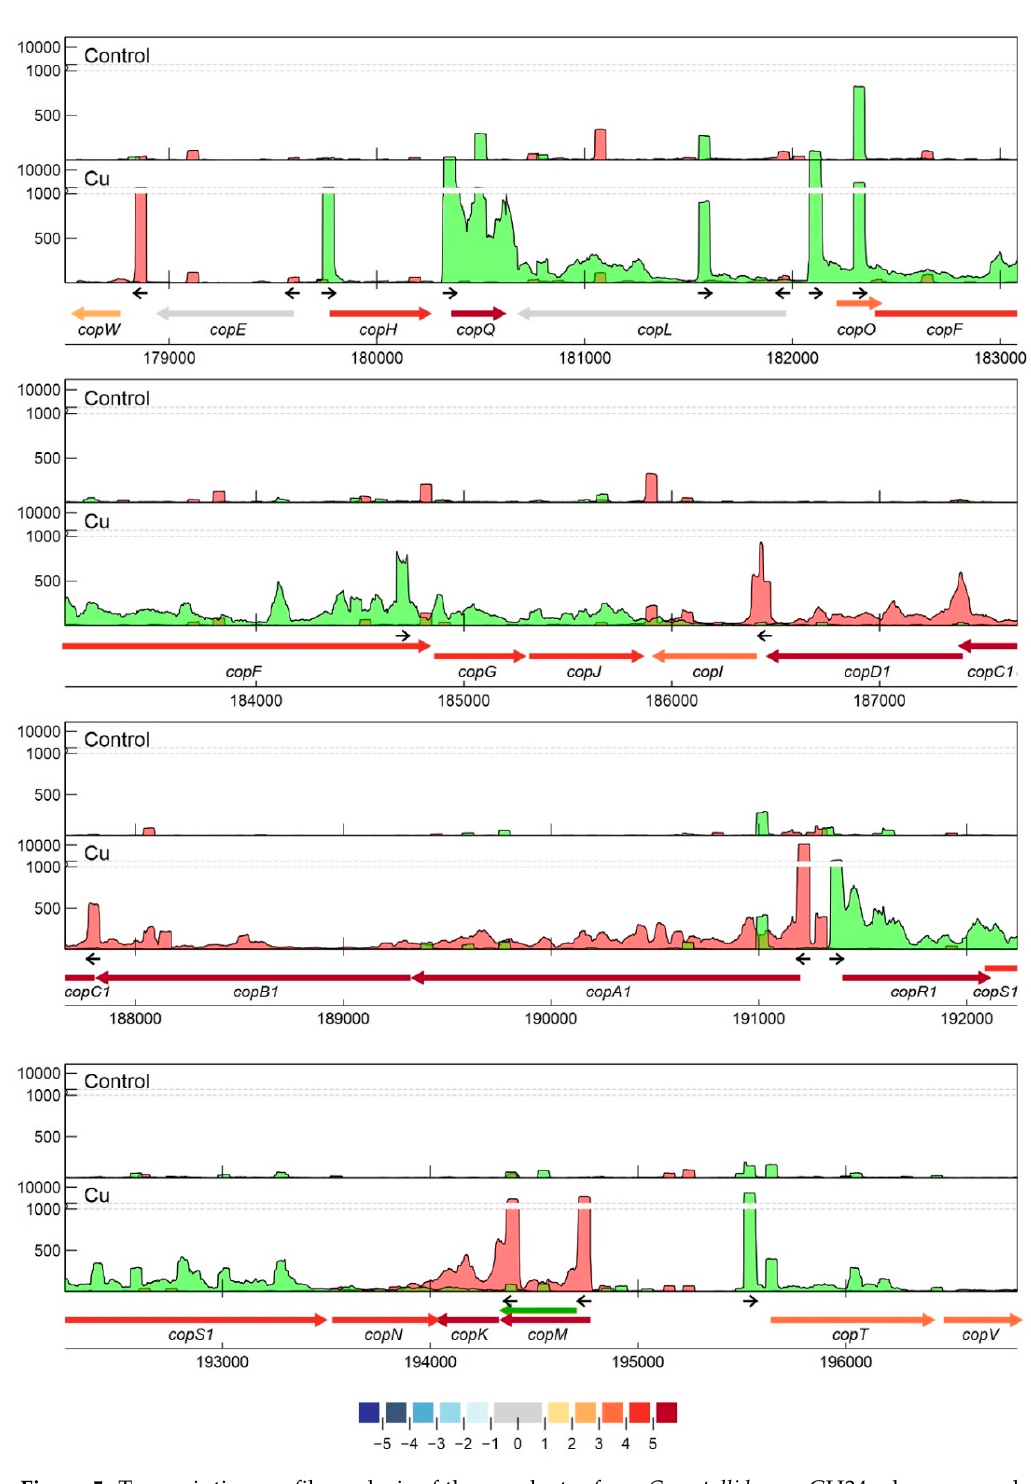
Figure 5. Transcription profile analysis of the cop cluster from C. metallidurans CH34 when exposed to copper. Combined TSS read counts of the three biological replicates for control (upper) and Cu condition (lower) are shown for positive (green) and negative (red) strands, with the y -axis containing a break pair (1000–1200) represented as striped grey lines. CDSs related to the cop cluster (coordinates for the pMOL30 region shown at the bottom) are colored based on their log 2 fold change. The small black arrows indicate clearly identified primary and internal TSSs. The green arrow represents a re-annotated